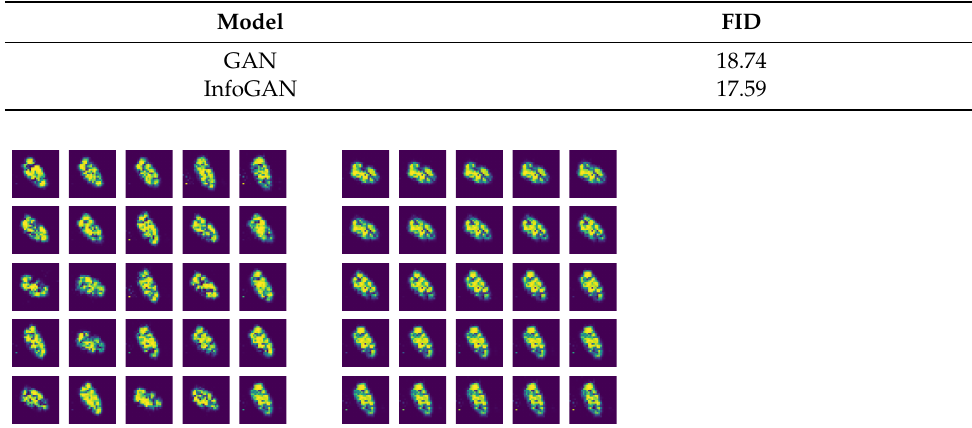
Figure 3. The comparison of generated SAR images between GAN and InfoGAN. The rotation angles are not controllable in GAN ( left ). The rotation angles are highly related to the latent code, c 1 ( right